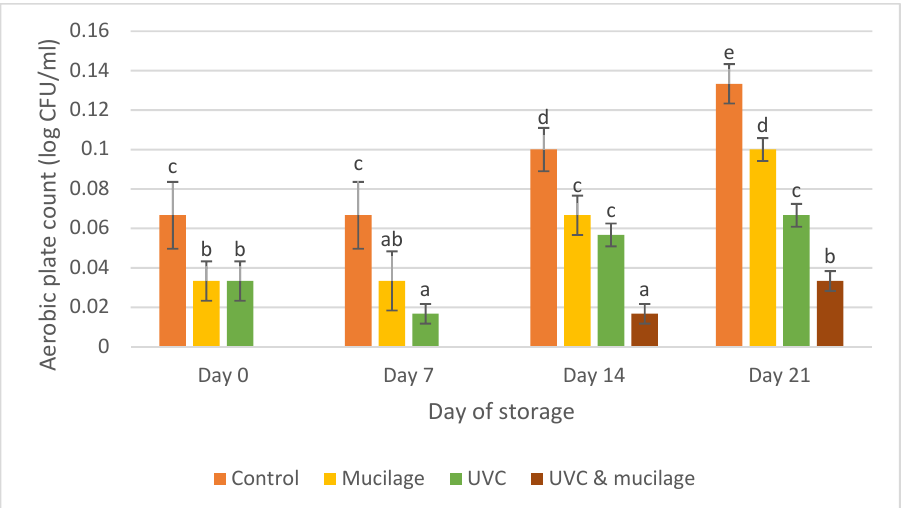
Figure 9. Effect of mucilage coating and UV-C on microbial analysis. Values followed by different letters within the same column are significantly different ( p < 0.05) ( n = 12).